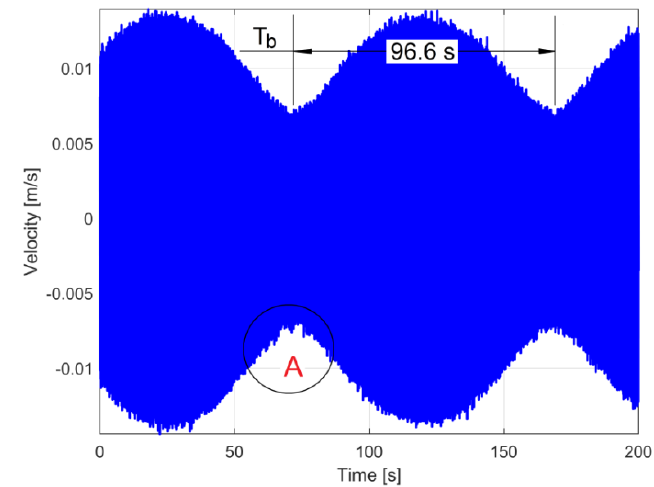
Figure 3. The evolution of the velocity of headstock vibrations with a beating phenomenon due to rotary unbalanced shafts; here T b is the beat period, A is a label for a future comment on signal